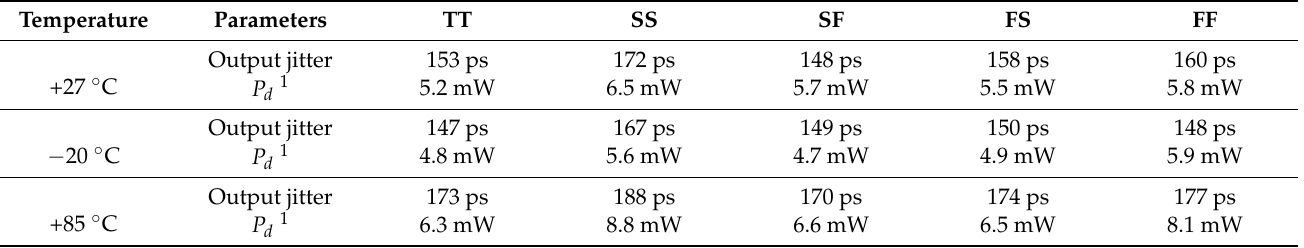
Table 2. Simulation results of the proposed clock multiplier under different corners and temperatures.